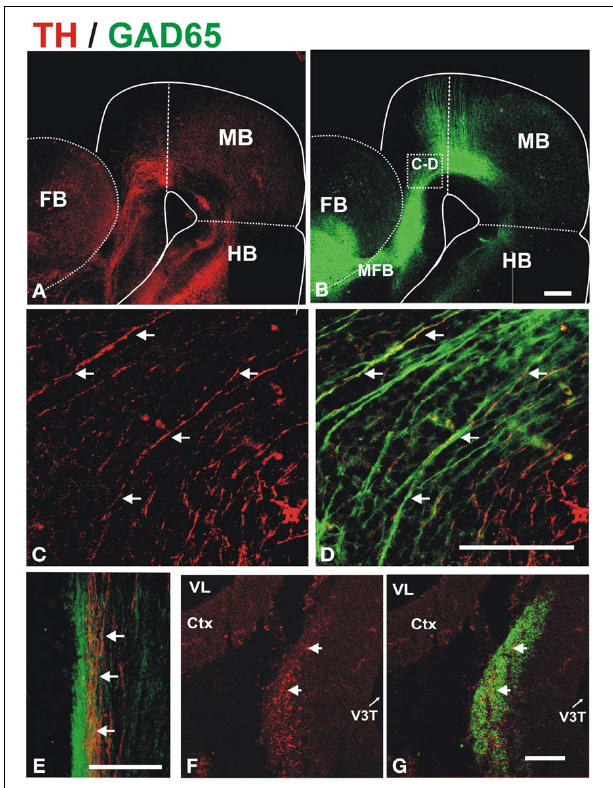
FIGURE 3 | Dopaminergic axons grow in close apposition to GAD65 axon bundles during mesostriatal projection (E12, E13). Whole brains (A–D) or frozen sections (E–G) from E13 (A–E) and E14 (F,G) embryonic rat brains were immunostained for TH (red) and GAD65 (green). (A,B) Show panoramic views of a flat-mounted hemibrain and the location of magnified field shown in (C,D) is indicated in (B) . The apposition observed in (C,D) was confirmed in single focal planes and in histological sections through the diencephalon in E13 (E) and E14 (F,G) embryos. Arrows in (C–G) indicate TH axons adjacent to GAD65 axons. Scale bar: 100 μ m.